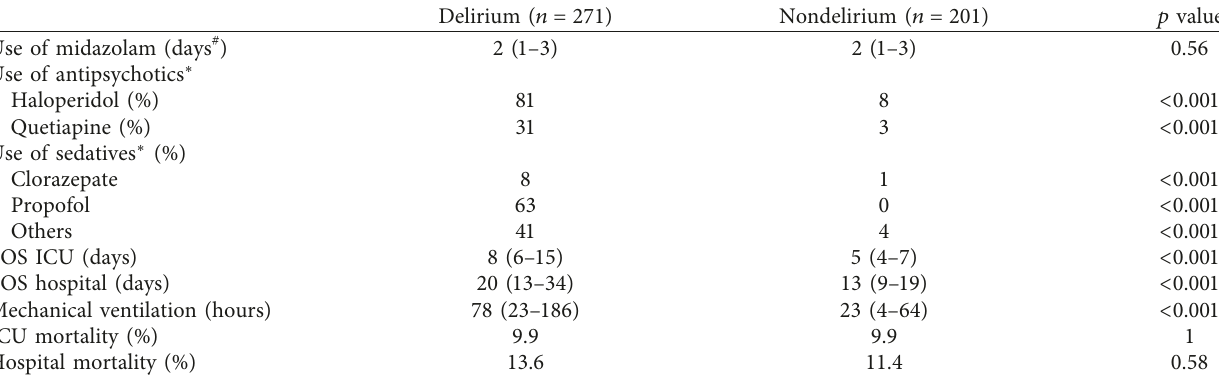
Table 4: Secondary analysis: main results.